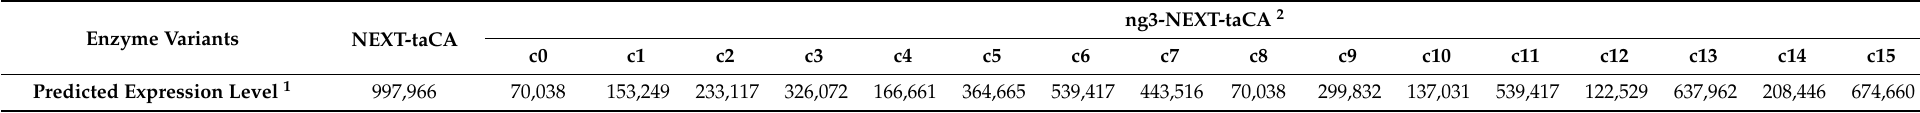
Table 3. Predicted expression level by the UTR